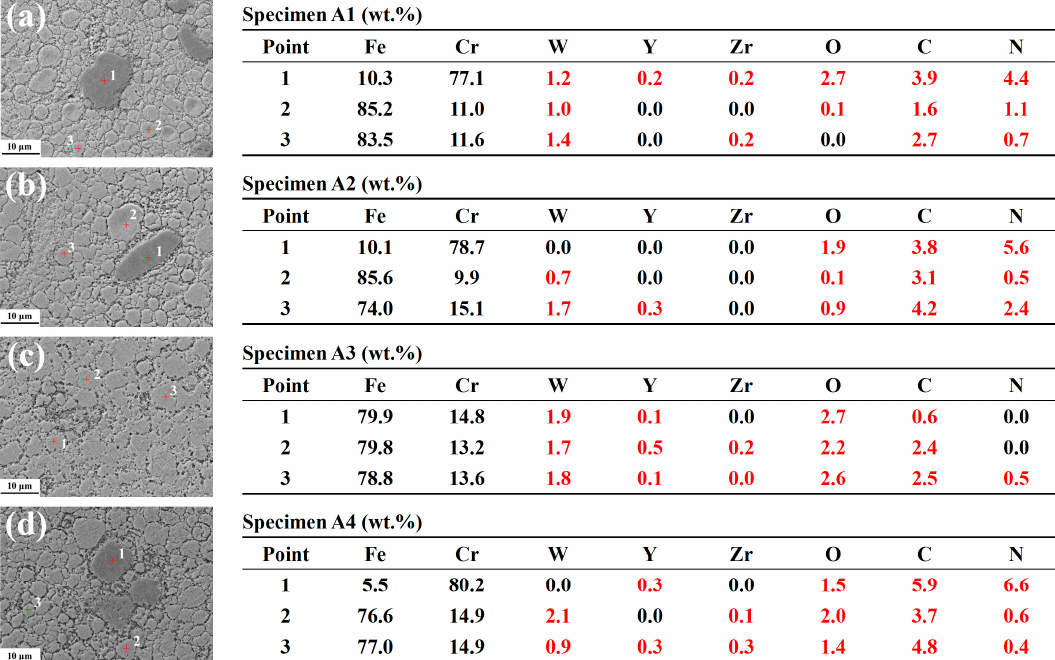
Figure 12. SEM images of sintered specimens: ( a ) A1, ( b ) A2, ( c ) A3, and ( d ) A4; ( e ) and ( f ) Precipi- tates of A4.